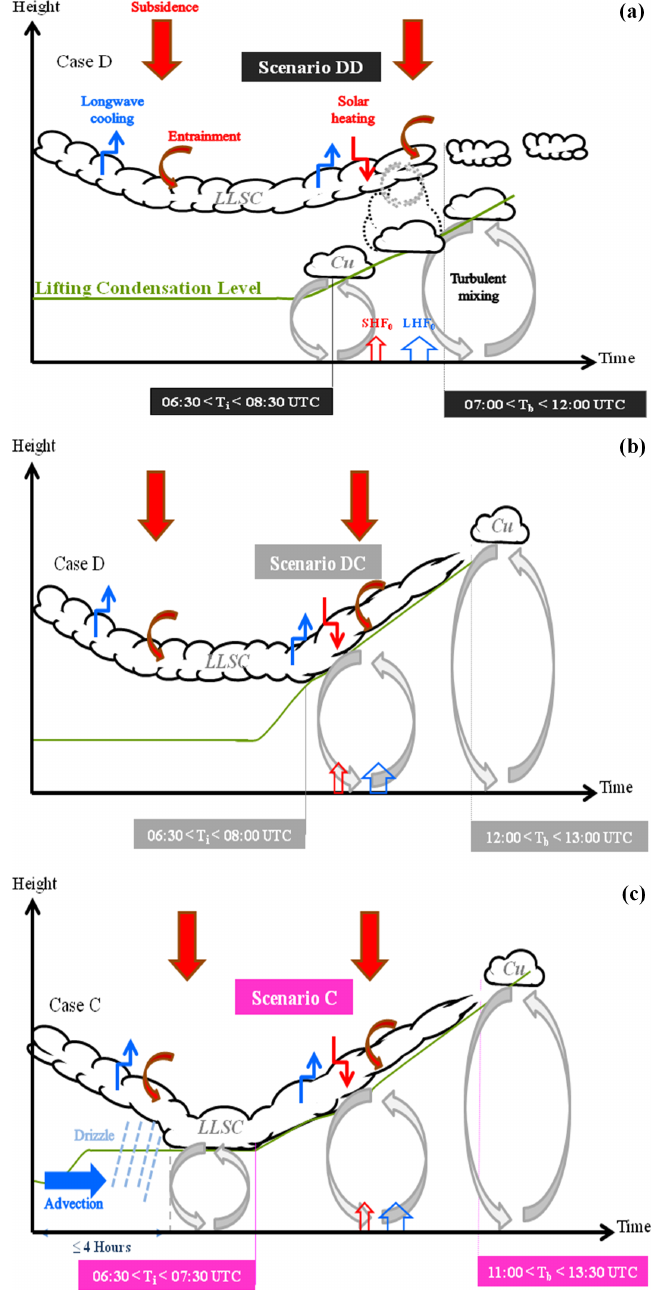
Figure 13. Schematic illustration of the main findings of this present study. It portrays the typical evolutions of the LLSC layer sampled at Savè, Benin (local time equals UTC + 1h) during the DACCIWA field experiment. The different scenarios and their characteristic times, as well as the relevant physical processes, are illustrated (the meaning of the different arrows is indicated in a and remains the same in b and c ). The representation encompasses stratus and convective phases of the LLSC diurnal cycle. The width of arrows representing the near-surface latent and sensible heat fluxes (LHF 0 and SHF 0 , respectively) corresponds to their relative proportions. Typically, the LLSCs are decoupled from the surface at formation (a, b, c) . For D cases (a, b) , the LLSC remains uncoupled all along the stratus phase. For C cases (c) , the LLSC gets coupled with the surface within 4h after its formation as the cloud base descends significantly and LCL increases potentially because of drier and cooler horizontal air advection (horizontal blue-filled arrow in c ) and drizzle formation in the subcloud layer (c) . In all C cases, the LLSC evolves by scenario C, in which the cloud layer lifts with the growing convective boundary layer and the subsequent cloud deck breakup leads to shallow convective cloud formation. In scenario DD (a) followed by most of the D cases, surface-convection-driven cumulus forms below the LLSC deck before its breakup. The other D cases evolve by scenario DC (b) , in which the LLSC couples with the surface as the convective boundary layer top joins the LLSC base, and the subsequent LLSC evolution is similar to scenario